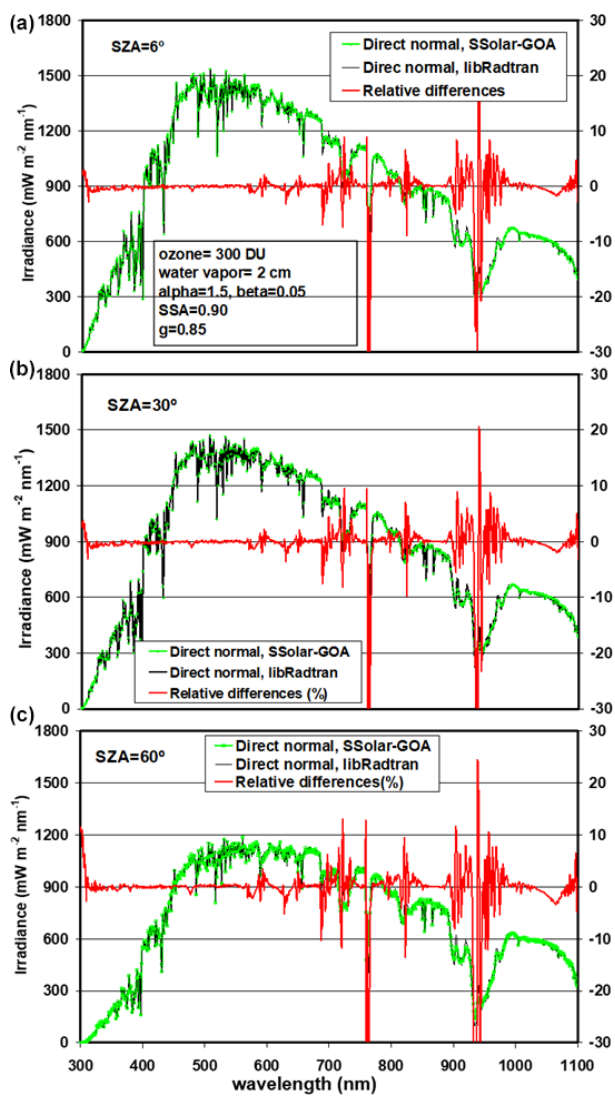
Figure 3. Comparison between libRadtran and SSolar-GOA models for direct normal irradiance at SZA = 6, 30, and 60 ◦ respectively (from top to bottom), with input parameters shown at the top of the figure. Right y axis indicates the relative differences in percentage in all figures ((libRadtran − SSolar-GOA) /